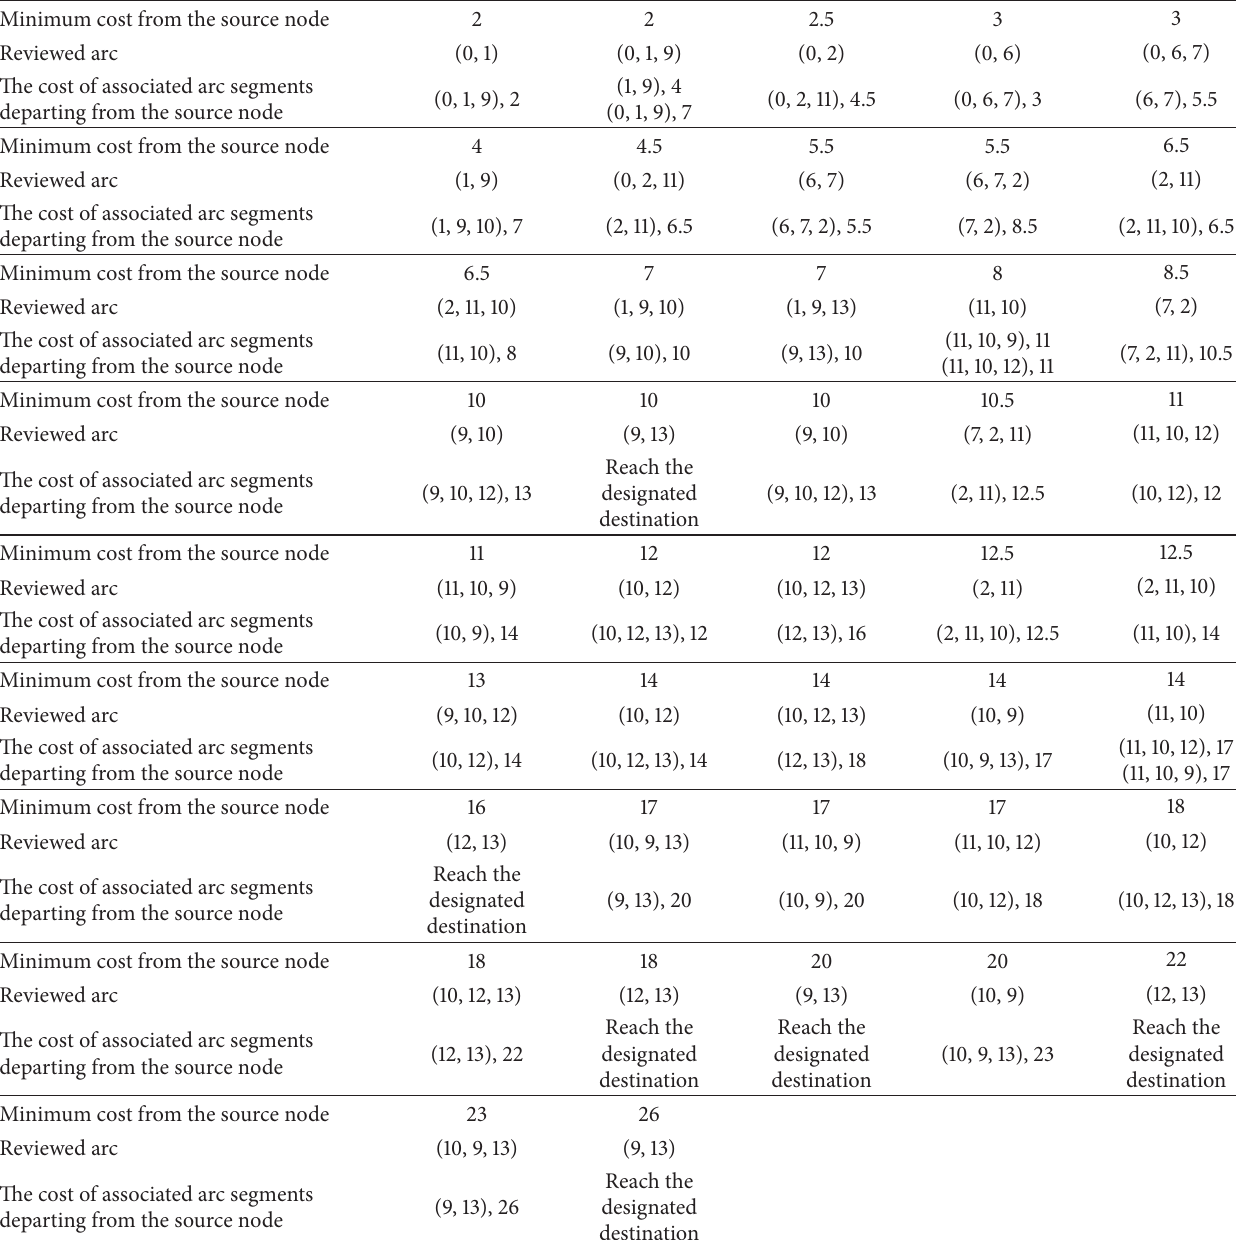
Table 5: Minimum-cost emergency evacuation route.